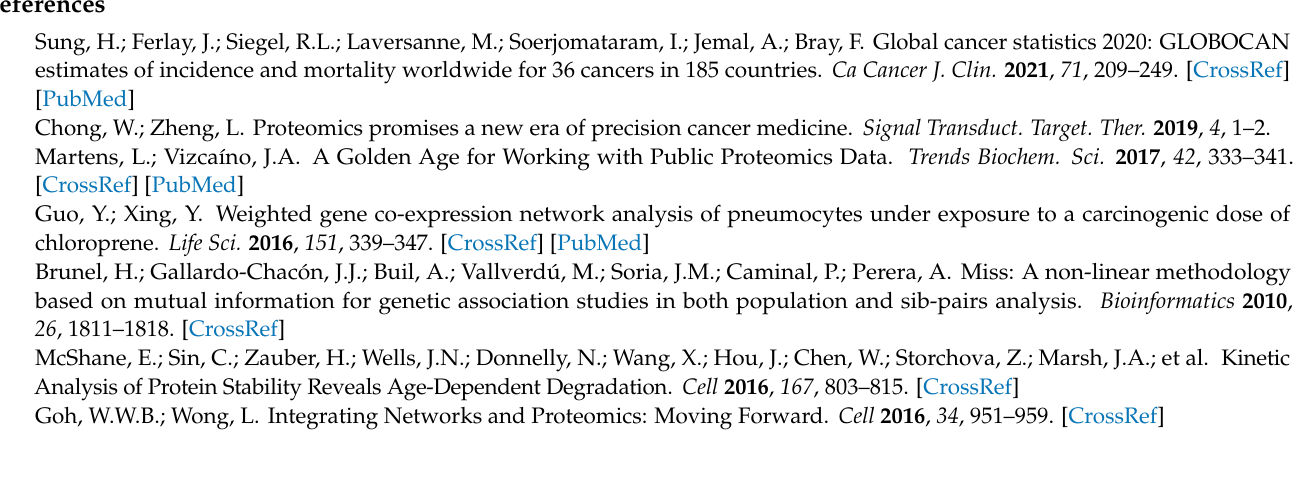
Table S2: Expression assortativity for each subcommunity with more than 10 interactions; Table S3: full proteomic differential expression analysis